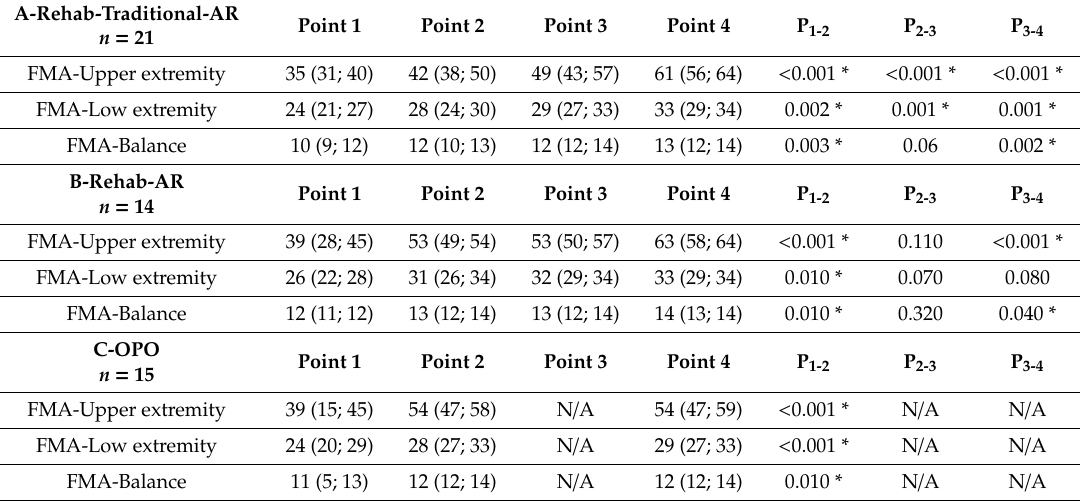
Table 3. Serum BDNF in patients with ischemic stroke and control